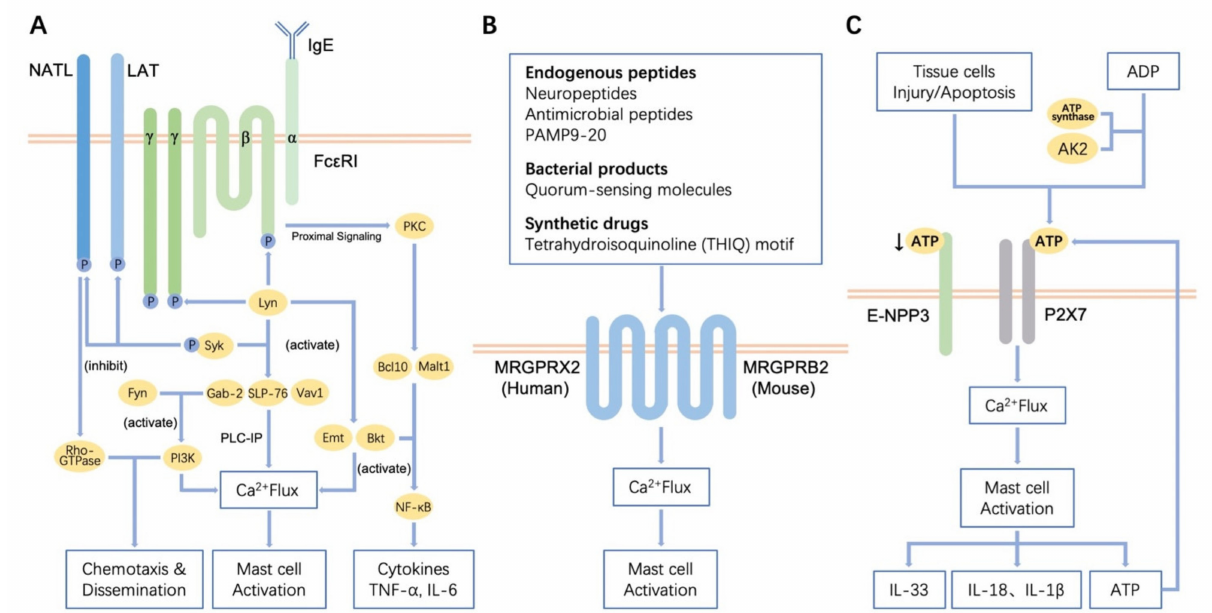
Figure 1. Regulation of receptor-mediated MCs activation. ( A ) IgE-Fc ε RI is the most classical mechanism of MCs activation, which mainly relies on the Lyn-Syk and Fyn pathways to activate MCs. ( B ) MRGPRX2/B2 is a novel class of G-protein- coupled receptors that can bind to various secretory proteins (mostly cationic peptides) to activate MCs. ( C ) P2X7 is an ATP-gated ion channel that is highly expressed in colonic MCs. P2X7 can also be activated by autocrine released ATP, and extracellular ATP can be degraded by E-NPP3 on the